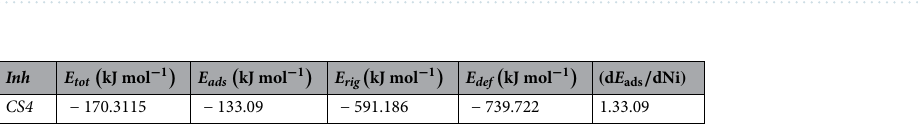
Table 6. The output energies calculated by Monte Carlo simulation for CS4 on Fe (110).